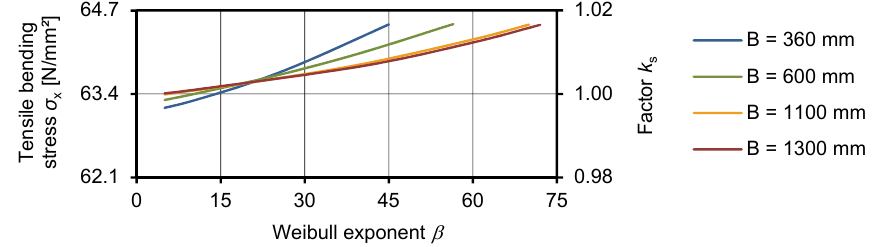
Fig. 8 Effective bending stress values and resulting factor k s at σ bth = 63.4 N/mm 2 as a function of the Weibull exponent.